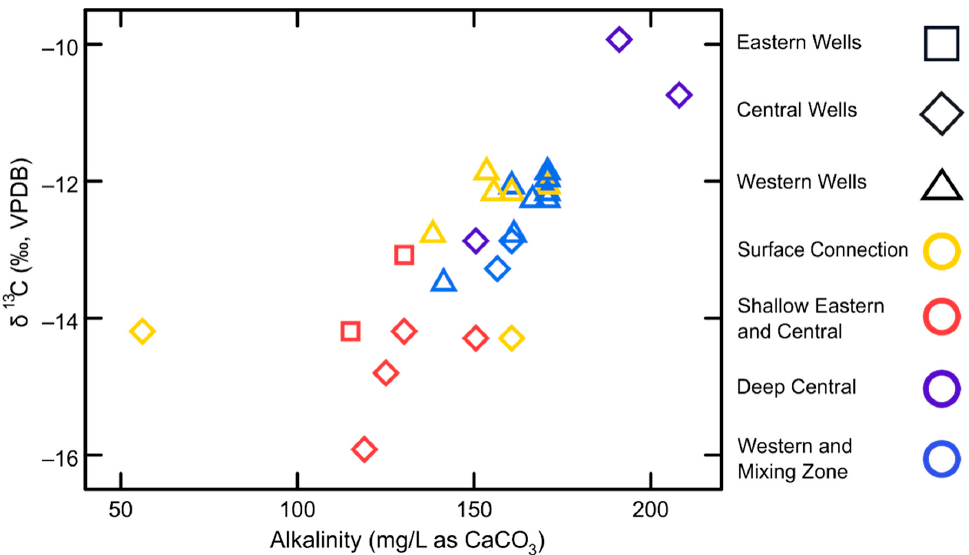
Figure 5. Measured values of δ 13 C and alkalinity (as CaCO 3 ) concentrations for groundwater samples collected from wells in the South Fork Palouse River Basin.